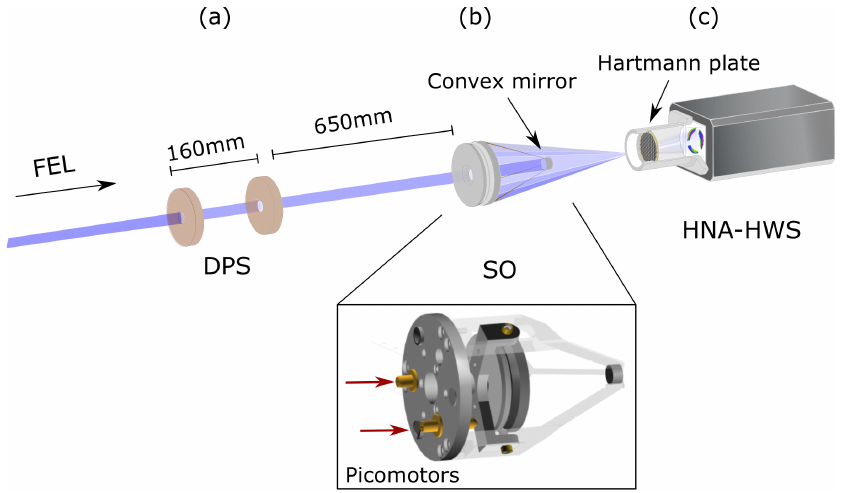
Figure 1. Experiment setup at FLASH. ( a ) Radiation clipped by aperture set (differential pumping stage, DPS) in front of Schwarzschild objective. ( b ) Schwarzschild optics reflects the radiation from FEL and ( c ) focuses it upstream of the Hartmann plate of high-numerical-aperture Hartmann wavefront sensor